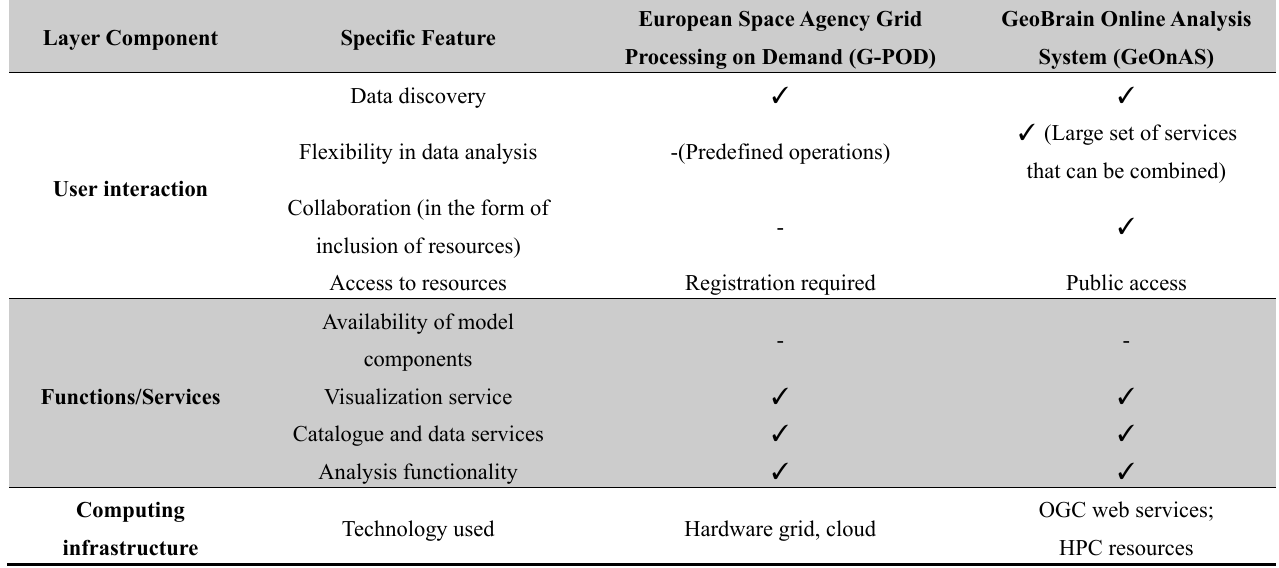
Table 2. A comparison of a geospatial cyberinfrastructure and a geoprocessing web